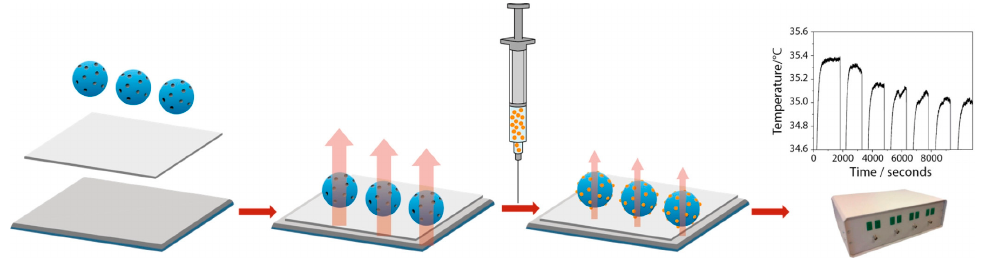
Figure 8. Representation of HTM analysis after glucose rebinding to the MIP-based platform. Figure reproduced with permission from ref. [87].